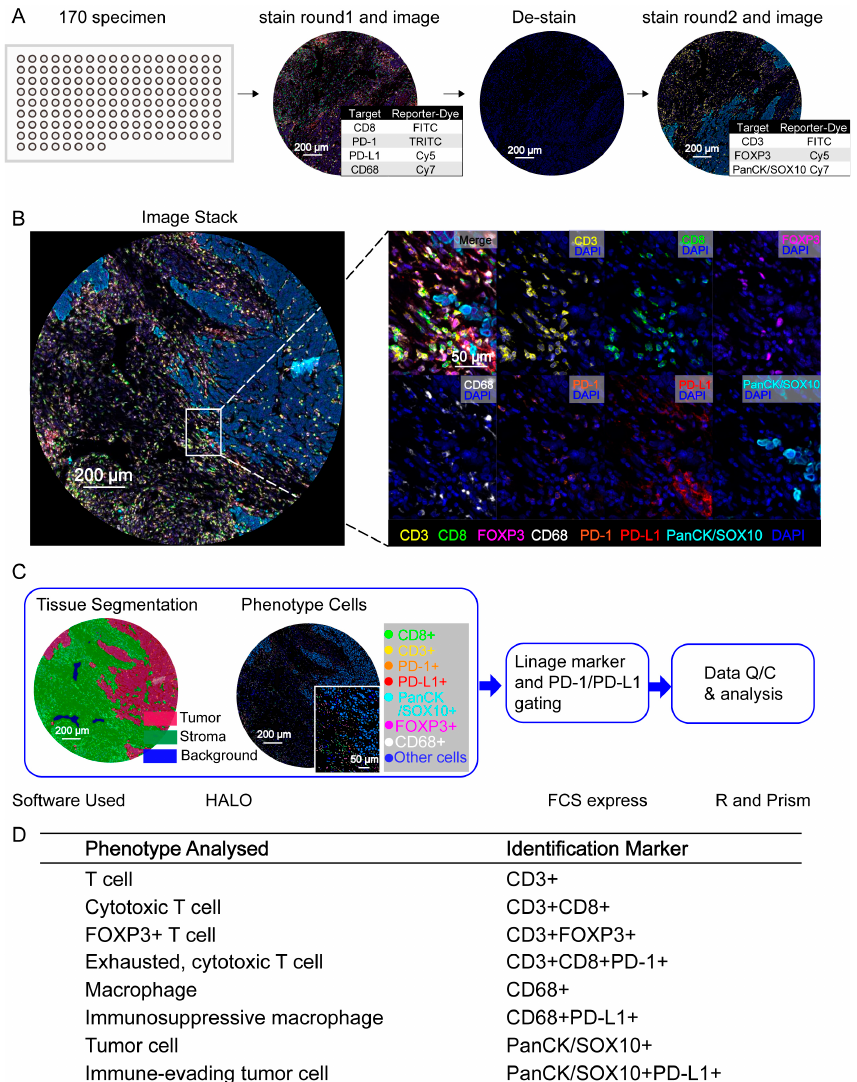
Figure 1. Characterization of cell phenotypes in PDAC tissues by InSituPlex multiplex staining technology. ( A ) A two-round multiplex staining assay and whole-slide digital scanning were performed in PDAC TMA, and the representative multispectral images (MSIs) of one TMA core are shown. ( B ) Simultaneous assessment of all markers using the “registration configure” functional module of the HALO software. The representative images show multiple staining patterns in the PDAC tissues. PanCK/SOX10 (a tumor cell marker) is shown in cyan; CD3 + T cells are shown in yellow; CD8 + cells are shown in green; FOXP3 + cells are shown in rose red; CD68 + cells are shown in white. The orange color indicates PD-1 + cells, and the red color indicates PD-L1 + cells. ( C ) The initial analysis was conducted using the HALO software. The tissues were segmented into tumor (red), stromal (green), and background (blue) regions based on DAPI + and PanCK/SOX10 + cells. The cells were then distinguished into different types according to the identified markers. For the image cytometry analysis, the data were exported to the FCS Express 7 software to gate specific cell populations, and R and Prism were implemented for further analysis and data visualization. ( D ) Cell phenotypes identified by hierarchical gating of lineage-selective and functional biomarkers during image cytometry analysis of mIHC